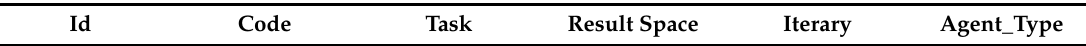
Table 5. Mobile agent data format.